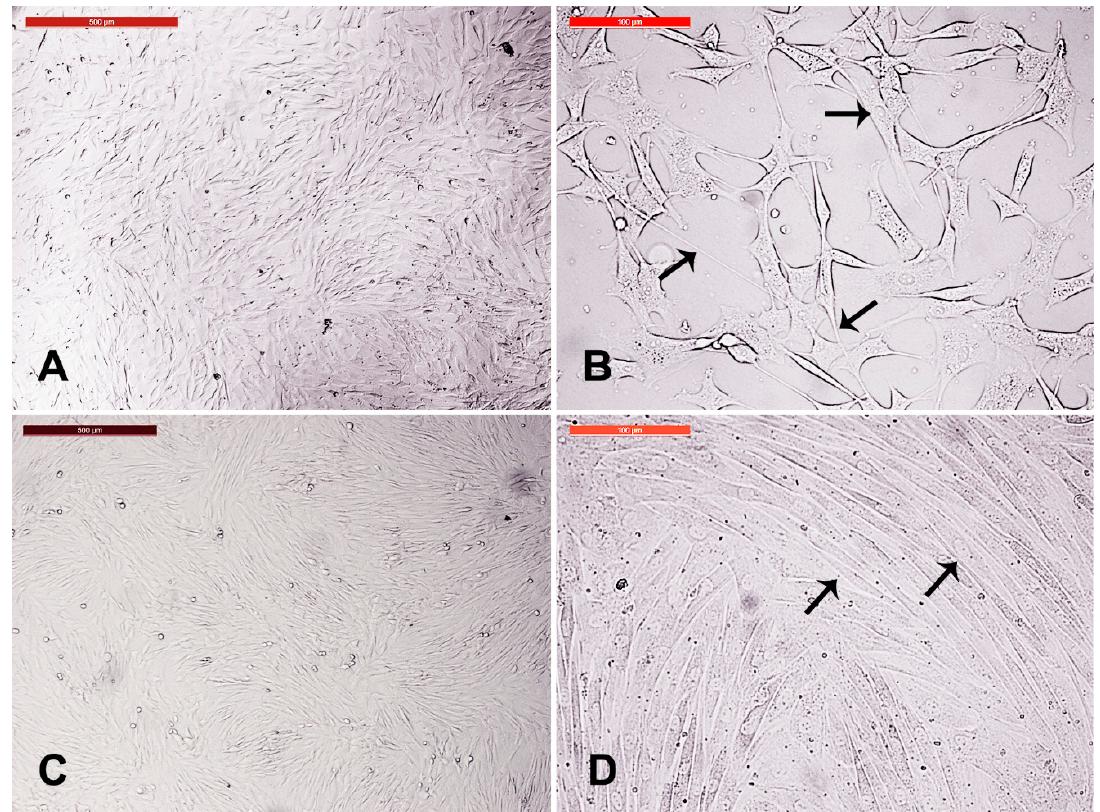
Figure 5. Fibroblast subculture and cryopreservation. Fibroblast were isolated morphologically and based in sensitivity to trypsin, were subcultured, and cryopreserved. ( A ) Fibroblasts at passage 1 (P1) at 70% confluency, and ( B ) magnified image to show spindle morphology (arrows). Cells were cultured to reach 90% confluency, harvested, and cryopreserved in liquid nitrogen. ( C , D ) Thawed and resurrected fibroblast at 90% confluency with clear spindle morphology (arrows). Scale bar of ( A , C ) = 500 µm. Scale bar of ( B , D ) = 100 µm.